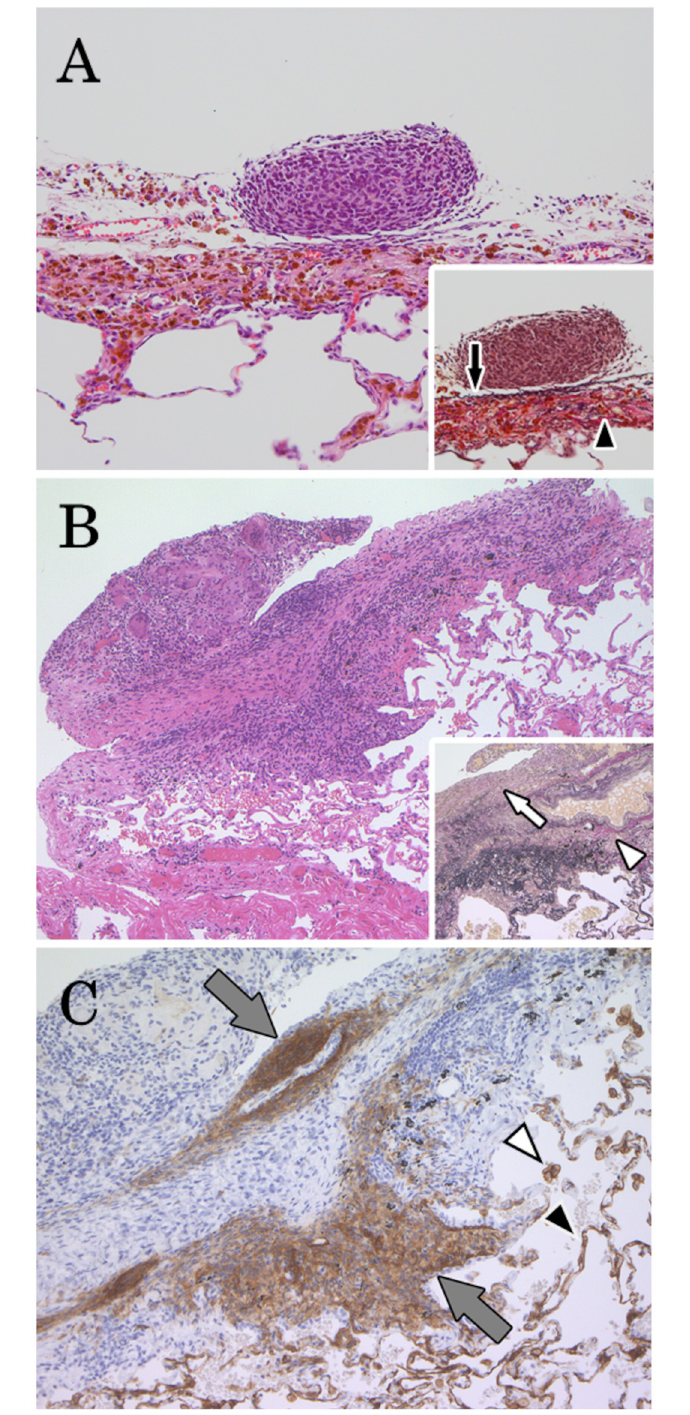
Fig 3. Localization of endometriotic lesions in the visceral pleura. (A) Endometriotic tissue adhered to the surface of the visceral pleura. Note that marked hemosiderin deposition was observed in the entire pleural wall. (Hematoxylin- Eosin stain, inset: the external and internal elastic layer were indicated by black arrow and arrowhead, respectively (Elastica von Gieson stain)). (B) Endometriotic lesions surrounded by granulation and/or fibrous tissue accompanied with inflammatory cells invaded into the lung tissue through the visceral pleura. (Hematoxylin-Eosin stain, inset: white arrow and arrowhead indicated the break of the external and internal elastic layer caused by the invasion of endometriotic tissue, respectively (Elastica von Gieson stain)). (C) Endometriotic stromal cells in the